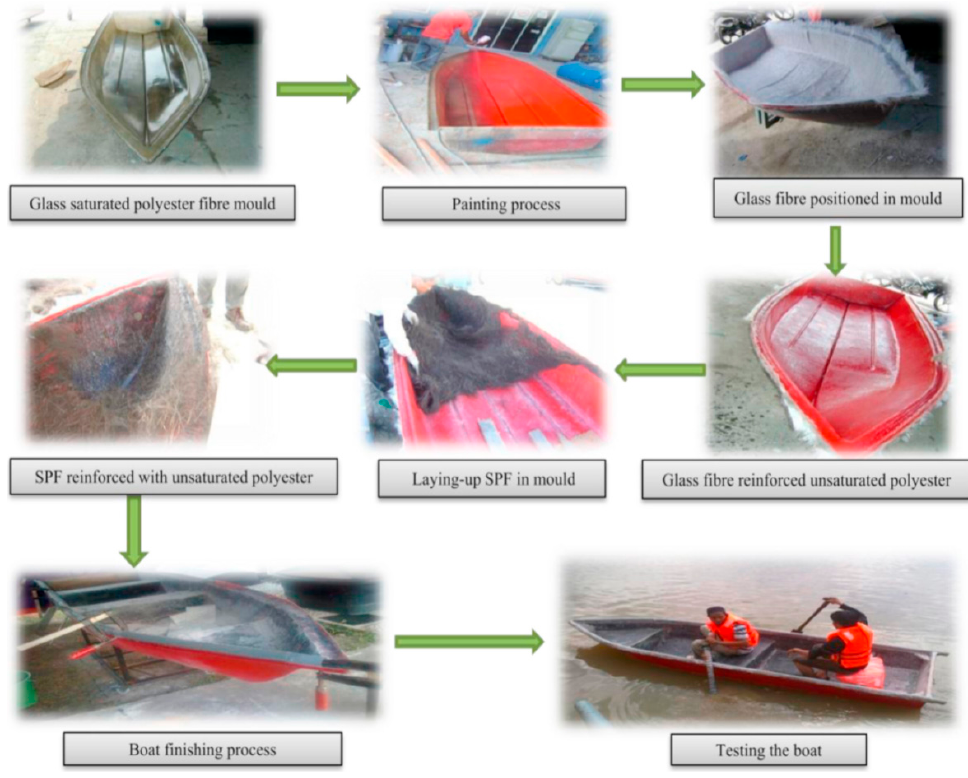
Figure 5. Fabrication of SPF/glass fibre reinforced UPE composites fishing boat. Adapted with permission from Ref. [52]. Copyright Elsevier.